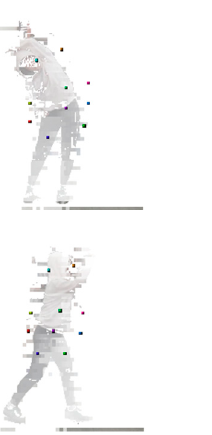
Figure A4. 3D landmarks generated when κ was 10 using RGBD images.